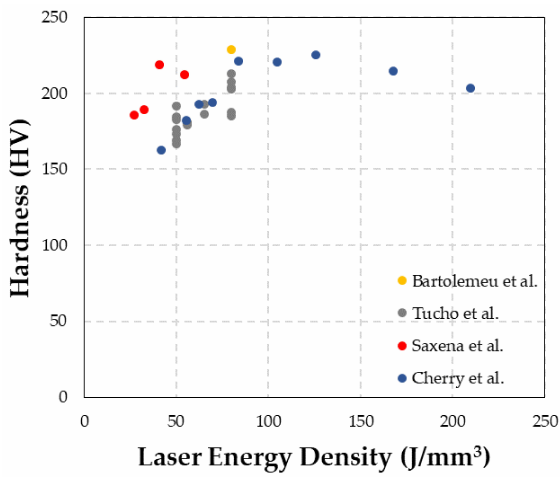
Figure 7. The relationship of laser energy density to microhardness for 316L SS